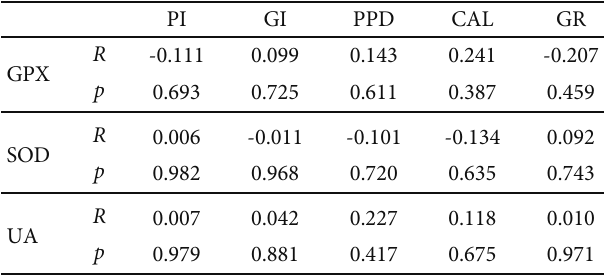
Table 4: Correlation among antioxidants and periodontal clinical parameters in the P